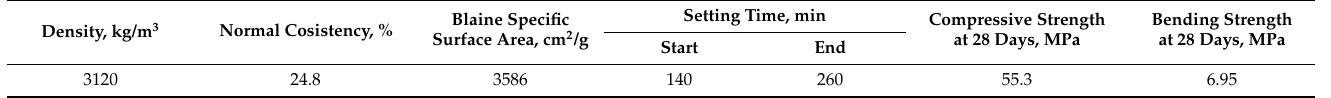
Table 1. Physical and mechanical characteristics of Portland cement.